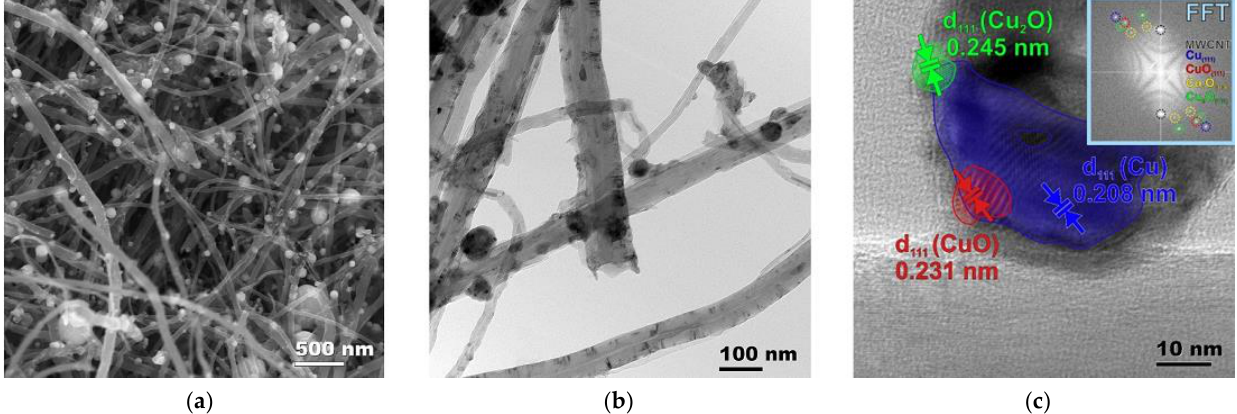
Figure 4. Electron microscopy images of the Cu/MWCNTs hybrid nanocomposite: ( a ) SEM; ( b ) TEM; ( c ) HRTEM of a lonely nanotube with the FFT pattern in insert.